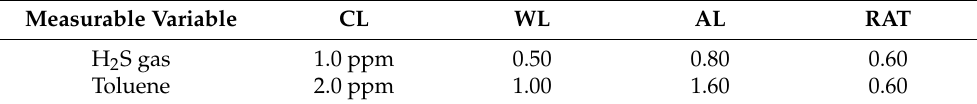
Table 1. Calculating the Relative Alarm Threshold (RAT).